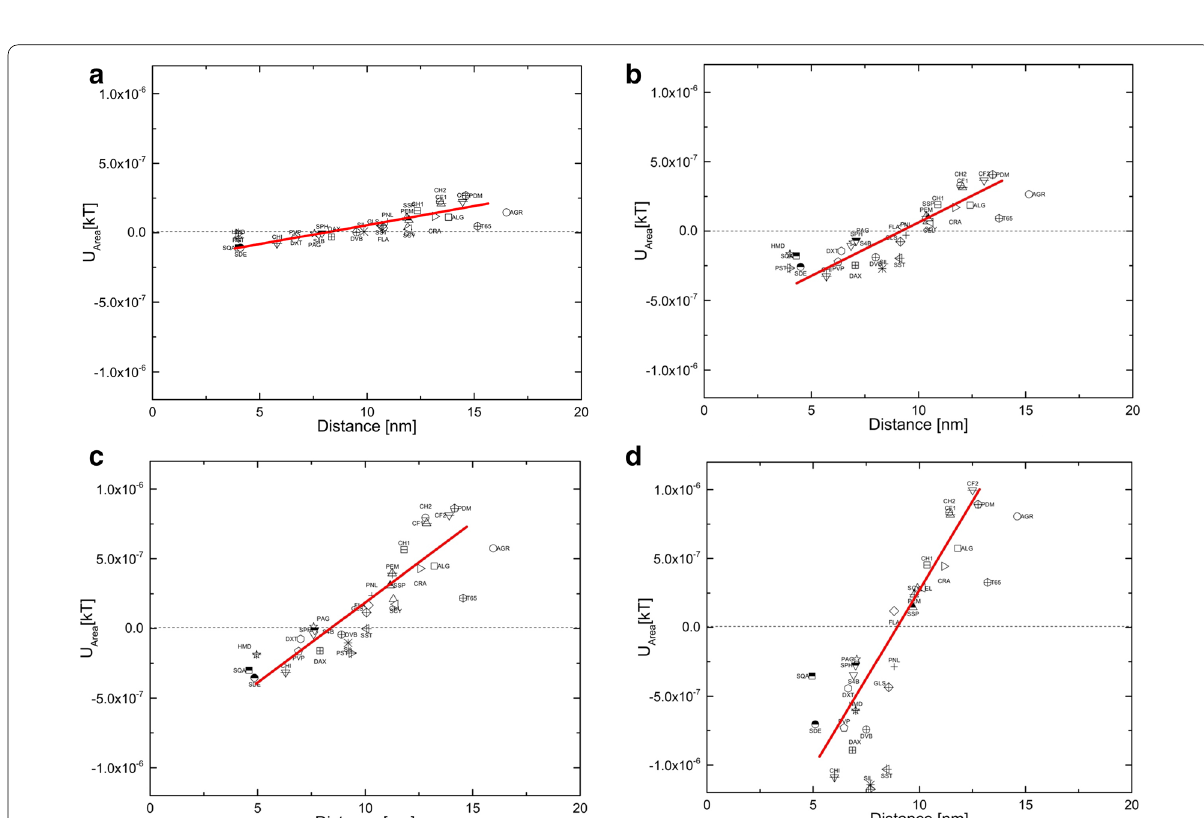
Fig. 2 The interaction energy Vs distance profiles of biomass as function of distance for a E. Coli , b B. subtilis, c S. cerevisiae and d CHO cells interaction with various polymeric beads in 20 mM phosphate buffer at pH 7.4, trend line on the graph is for representation of the